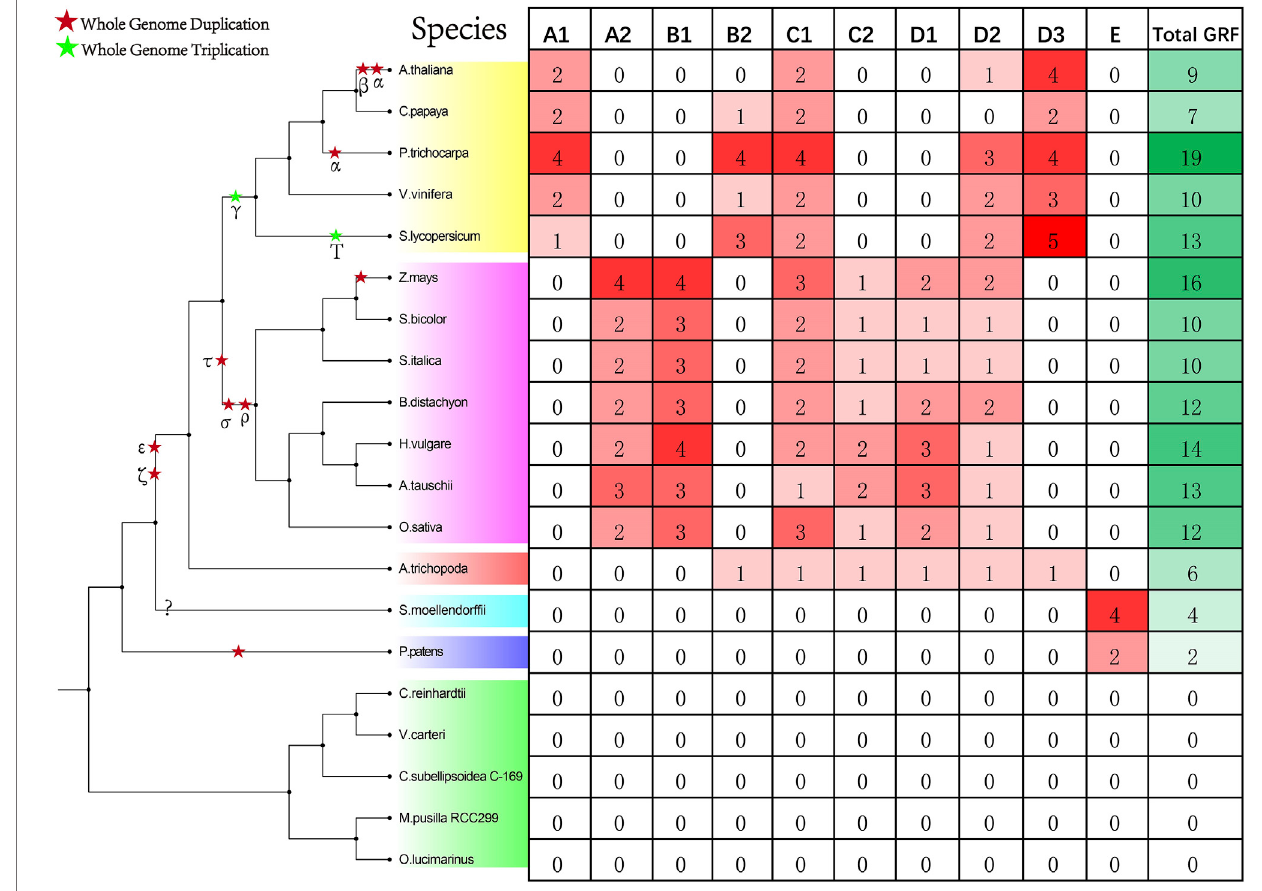
Frontiers in Genetics |